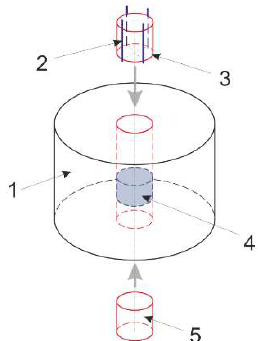
Figure 2. Four-point method of conductivity determination: 1—glass cylinder, 2—platinum/rhodium contact wires, 3—glass piston with incorporated platinum electrodes, 4—sponge, 5—glass support.